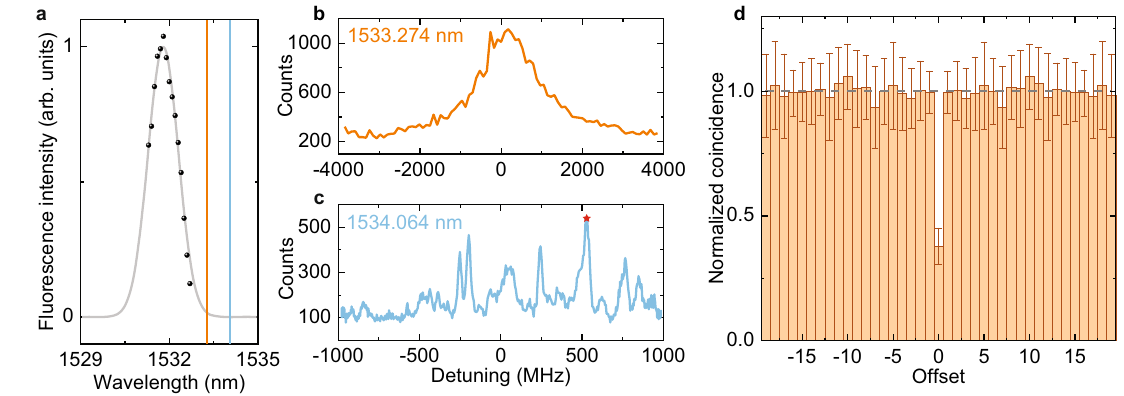
Fig. 3 | Single ion detection. a Inhomogeneous distribution of Er ions, measured by the fl uorescence intensity in the waveguide. Gray curve is a Gaussian fi t with FWHM of 160 GHz. Orange and blue lines indicate the frequency that the cavity is tuned to for fl uorescence spectrum measurement shown in panels b and c . b Fluorescence spectrum inside the resonance when it is tuned to 1533.274 nm. A continuous emission spectrum shows that an ensemble of ions are probed. c Fluorescence spectrum when the resonance is tuned further to the tail of